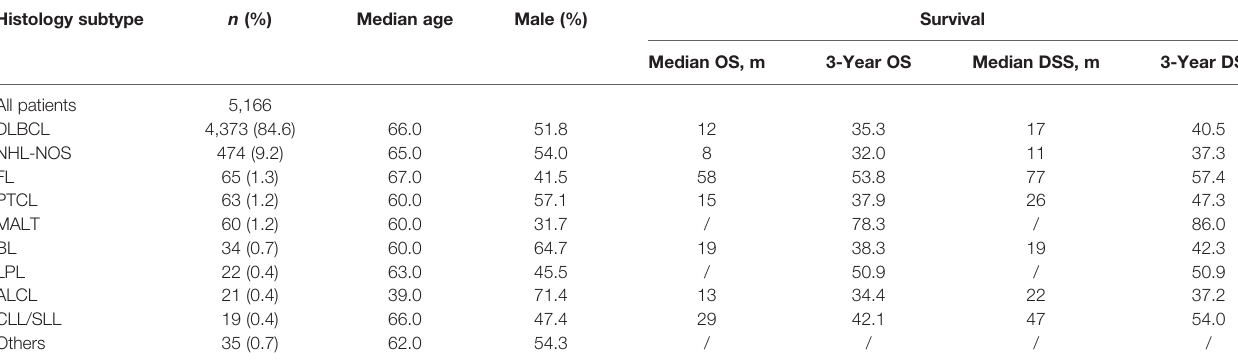
TABLE 2 | Patient characteristics according to histological subtypes. Histology subtype